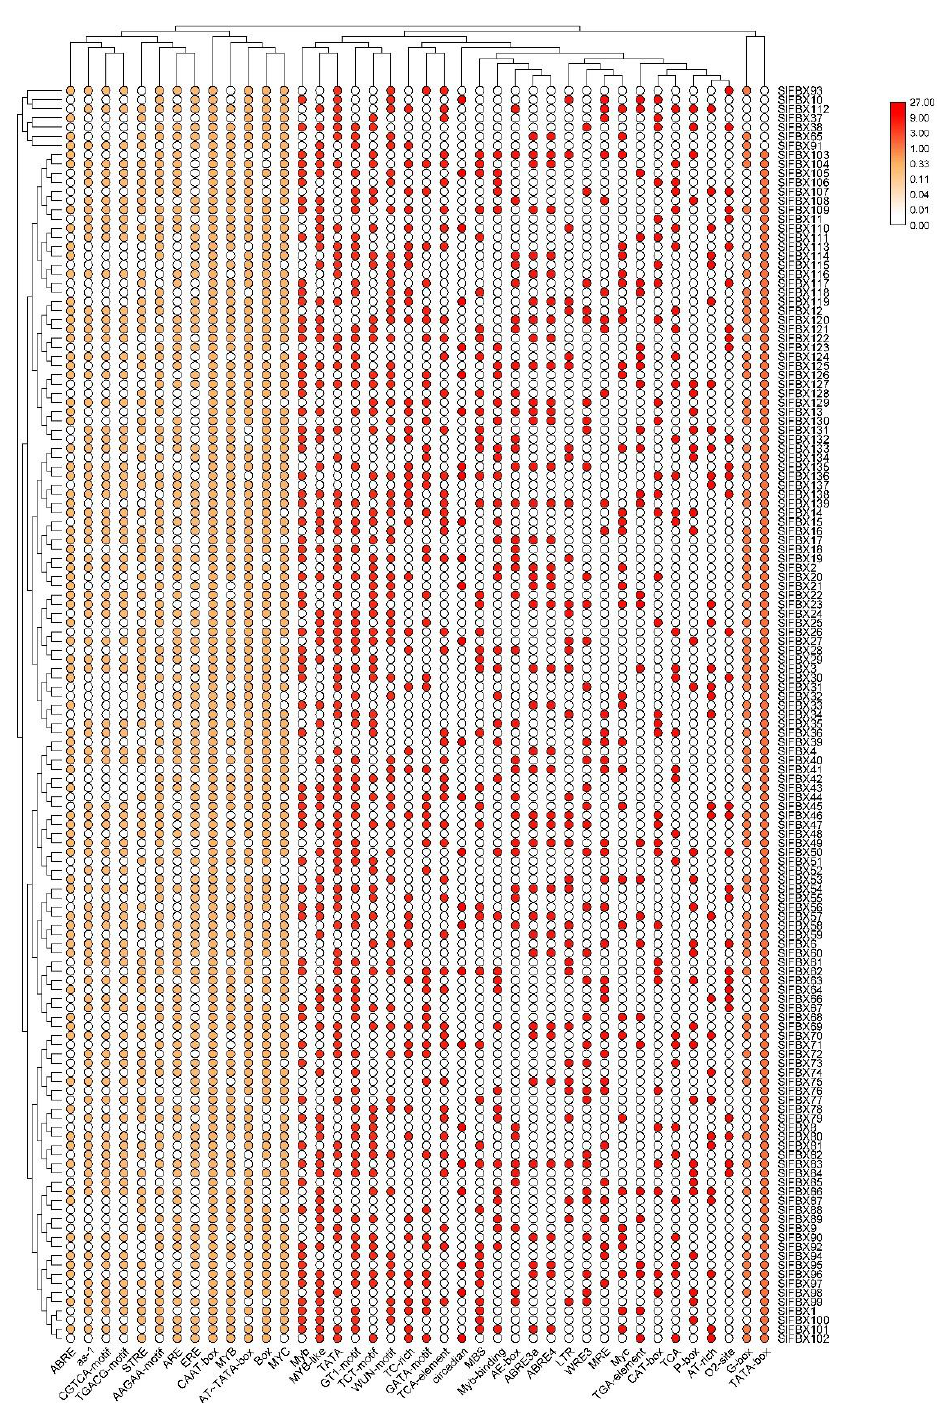
Figure 3. The cis-element of promoter in SlFBX gene family. The depth of the color represents the number of times cis-element